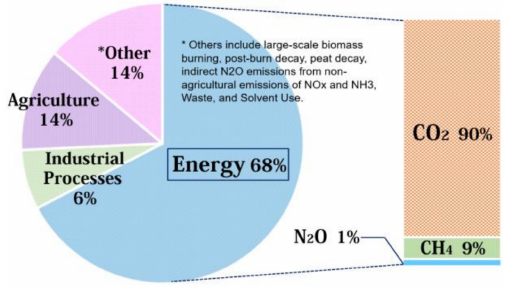
Figure 8. Estimated shares of global anthropogenic GHGs, 2014 [55].